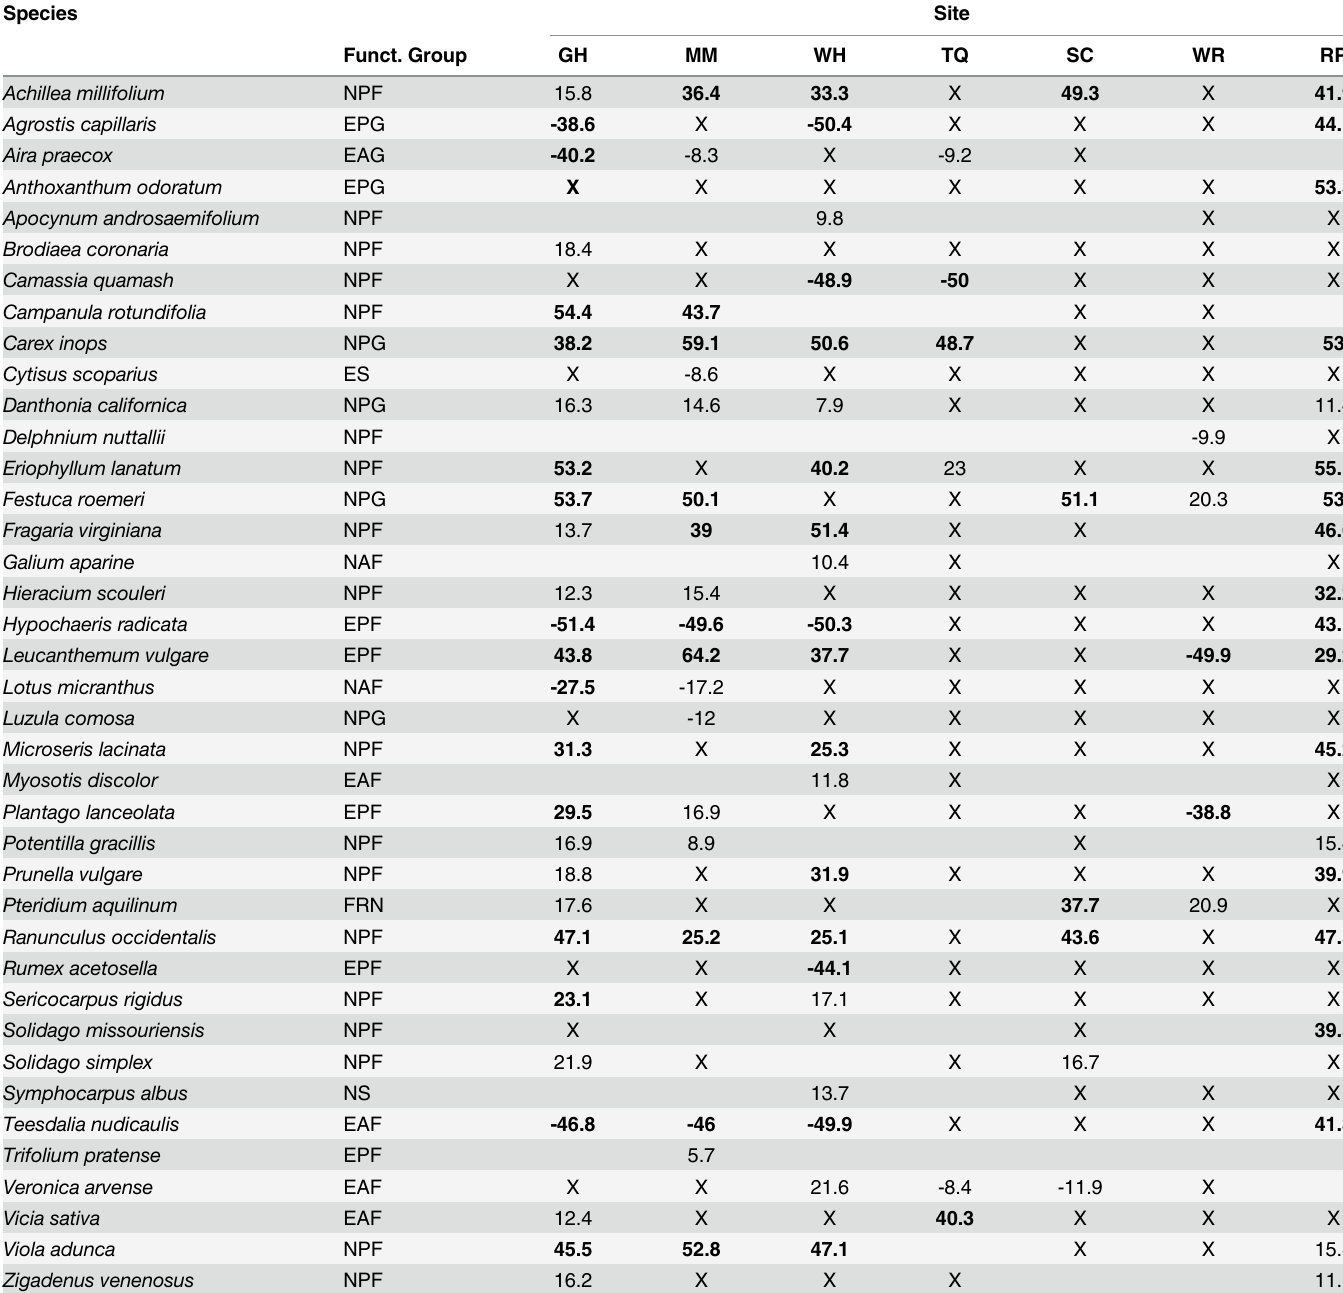
Table 2. Indicator Values of Species Associated with Presence or Absence of Golden Paintbrush.